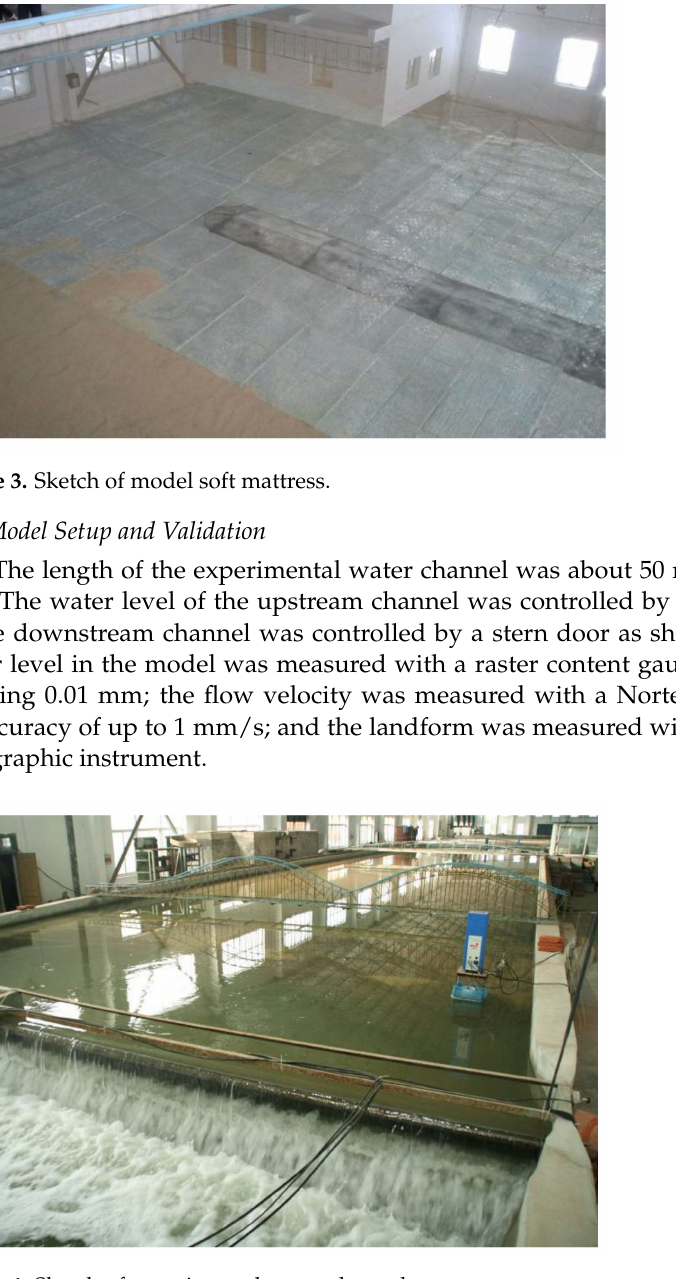
Figure 4. Sketch of experimental water